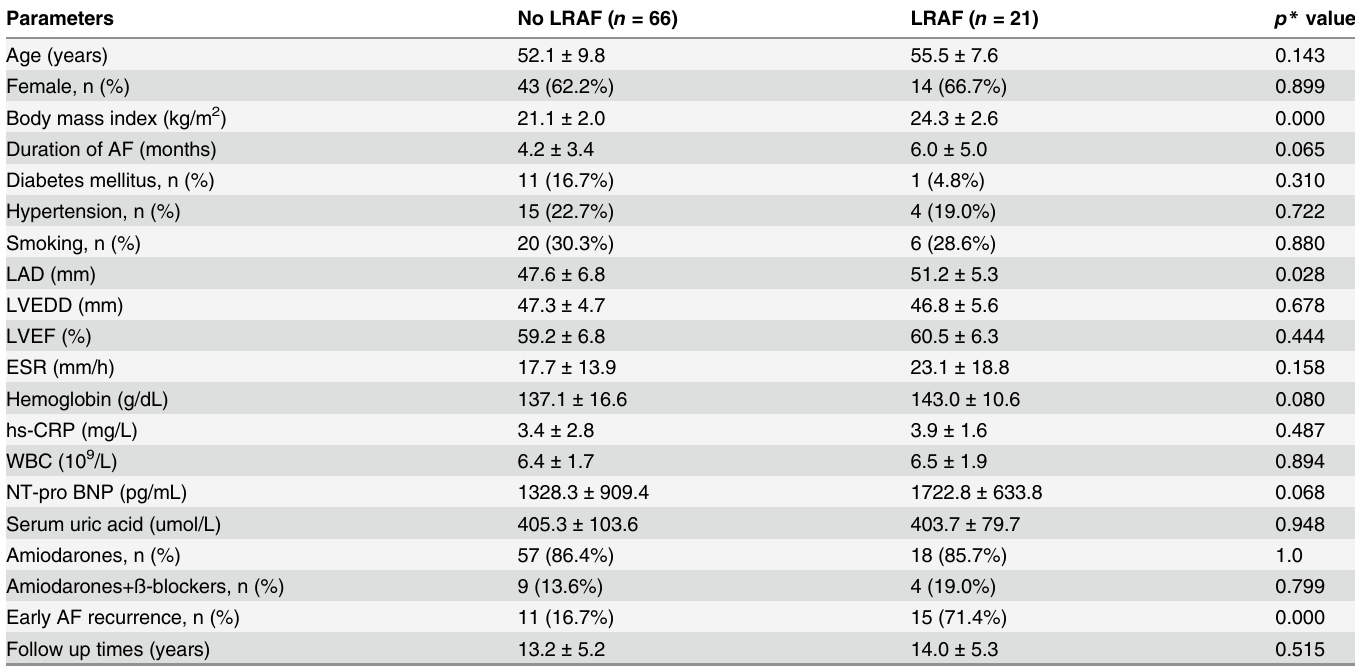
Table 2. Univariate analysis the relating risk factors for late AF